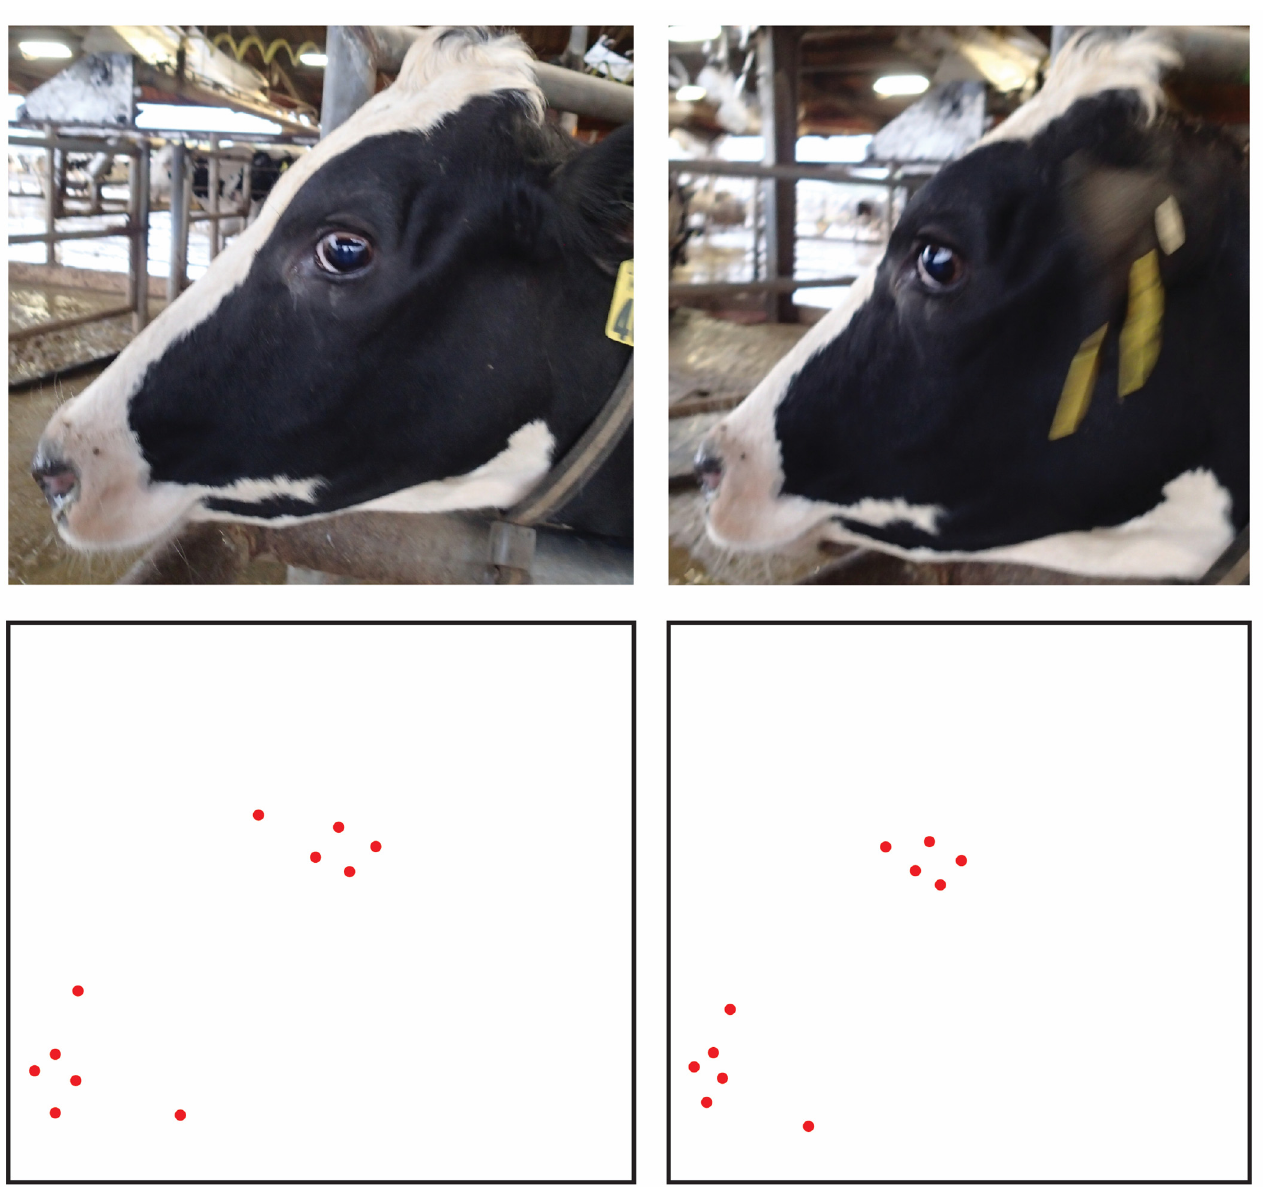
Figure 7. Demonstration of the impact out-of-plane variations in facial angle can have on the relative locations of anatomical landmark points. The change in angle between the 3D object and the 2D plane of the camera on which the image is being rendered can be described by homographic trans- forms. This geometric operation results in systematic changes in the relative position of landmark points, which would in turn produce correlations in between-photo error terms.